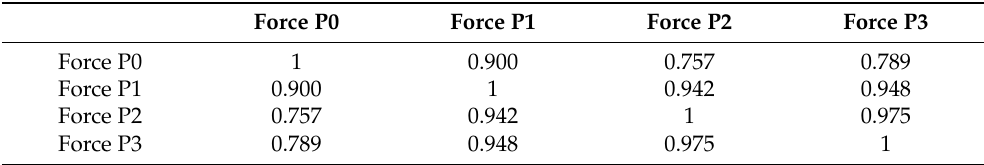
Table 11. Pearson’s correlations of the test’s strength at Rovisco